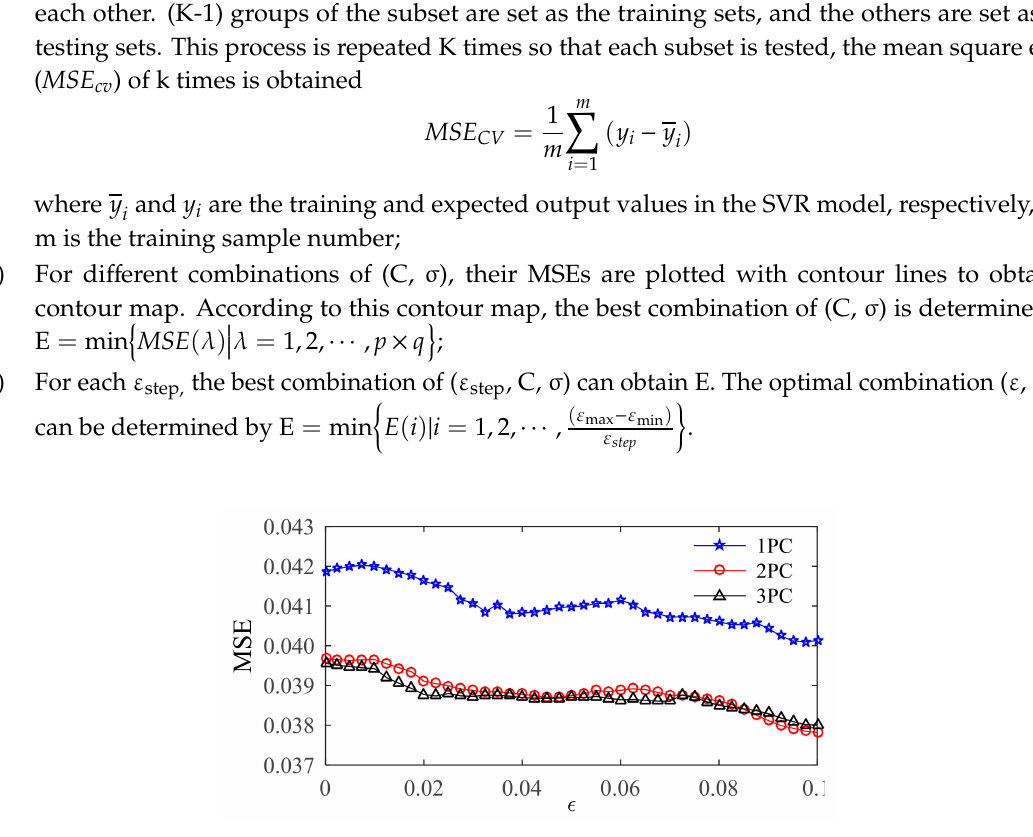
Figure 8. MSE value determined by